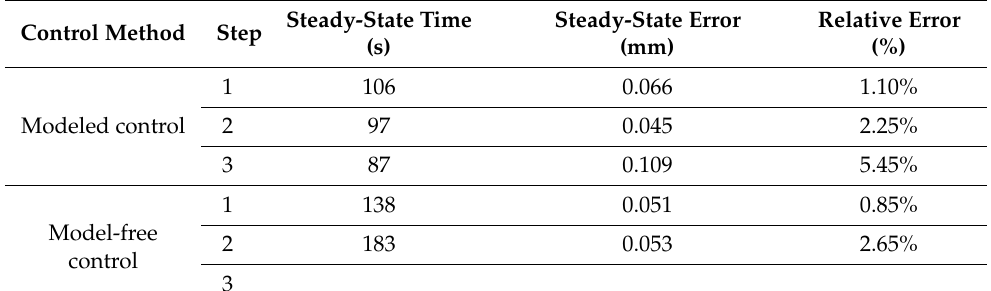
Table 4. Time-domain performance